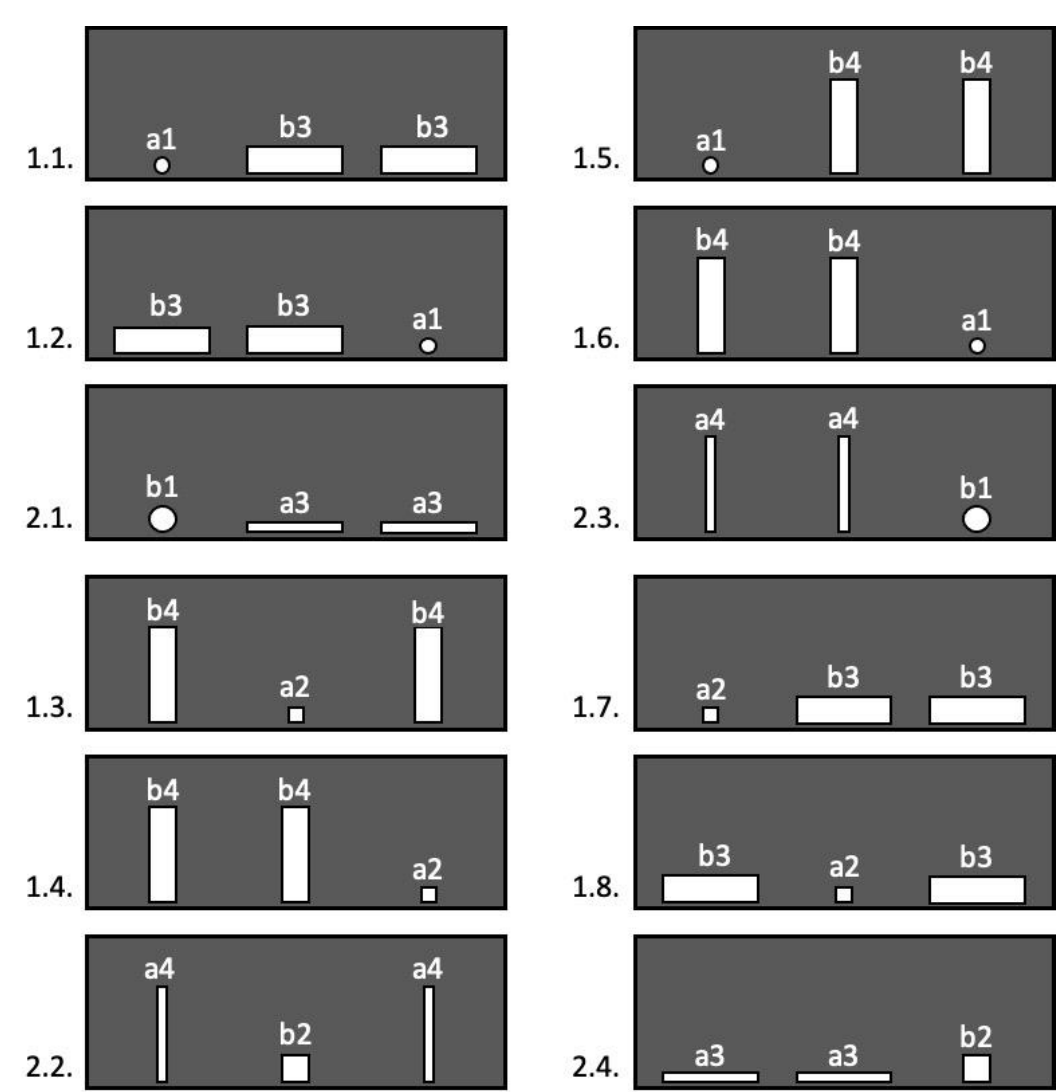
Figure 4. Location of holes during Experiment 2: 1.1. – 1.8. — successive background trials, 2.1. – 2.4. — successive test trials; a1 — impassable hole (Ø 40 mm), a2 — impassable hole with a side of 40 mm, a3 — impassable hole (horizontal rectangles 250 × 25 mm), a4 — impassable hole (vertical rectangles 25 × 250 mm), b1 — passable hole (Ø 70 mm), b2 — passable hole (square 70 mm), b3 — passable hole (horizontal rectangle 250 × 70 mm), b4 — passable hole (vertical rectangle 70 × 250 mm).